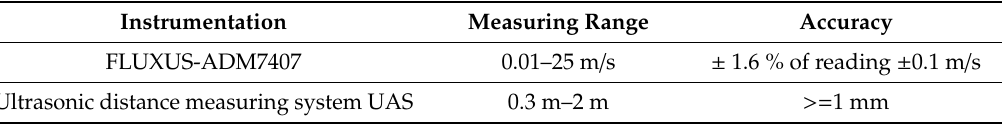
Table 1. Hardware specifications used in the